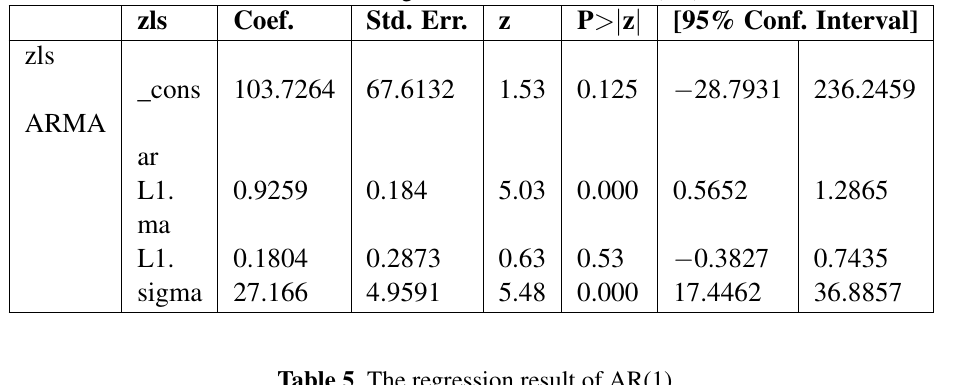
Table 4 The regression result of ARMA(1,1)